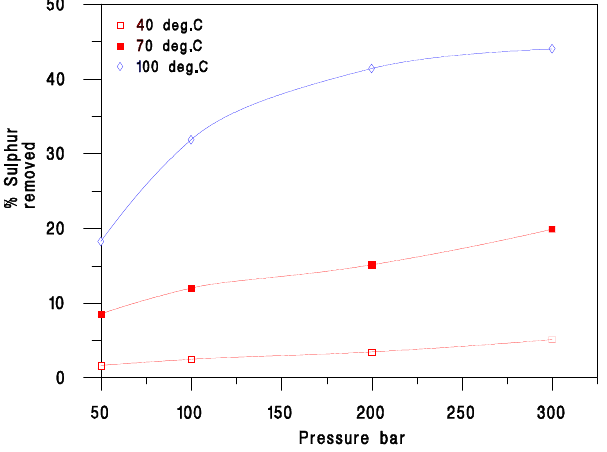
Figure 3. Effect of air pressure on pyritic sulphur removal for Silverdale coal.